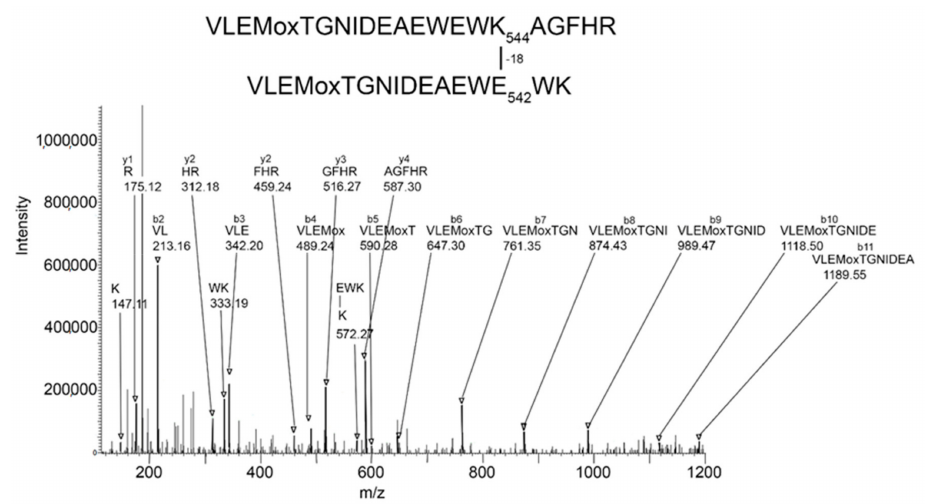
Figure 3. MSMS spectrum of peptide VLEMoxTGNIDEAEWEWK544AGFHR crosslinked to VLEMoxTGNIDEAEWE542WK through the crosslinking action of CPO. Annotated masses are from a b-ion sequence, and from two y-ion sequences that identify the crosslinked peptides. These peaks are darkened and denoted by an arrow. Most major peaks are part of these sequences. Most unannotated peaks are due to neutral losses of amine, water, or CO (a-ions). The parent ion mass is 897.01 m / z , charge state + 5.